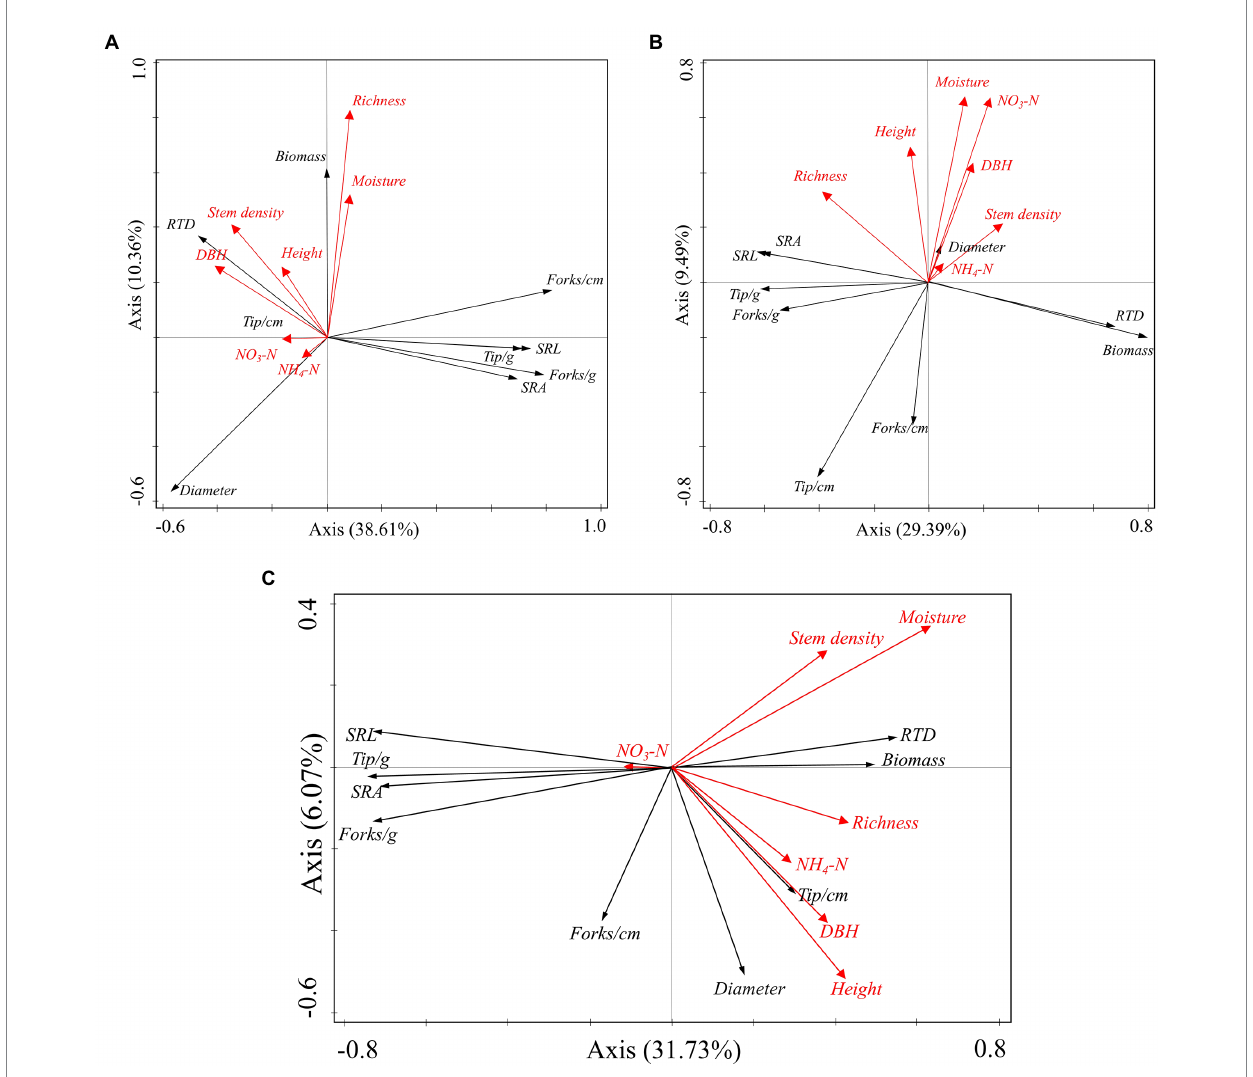
FIGURE 3 Redundancy analysis of environmental factors (soil and vegetation) and fine root indices (biomass and morphology). Environmental factors (indicated by red lines) were used to explain the changes in fine root biomass and morphology (indicated by black lines). (A) , July 2018; (B) , October 2018; (C) . January 2019; SRL, specific root length; SRA, specific root area; RTD, root tissue density; Tip/cm, root tip density; Forks/cm, root branching density; Tip/g, specific root tip density; forks/g, specific branching density. Vegetation index (DBH, height) refers to the average value of all species in the